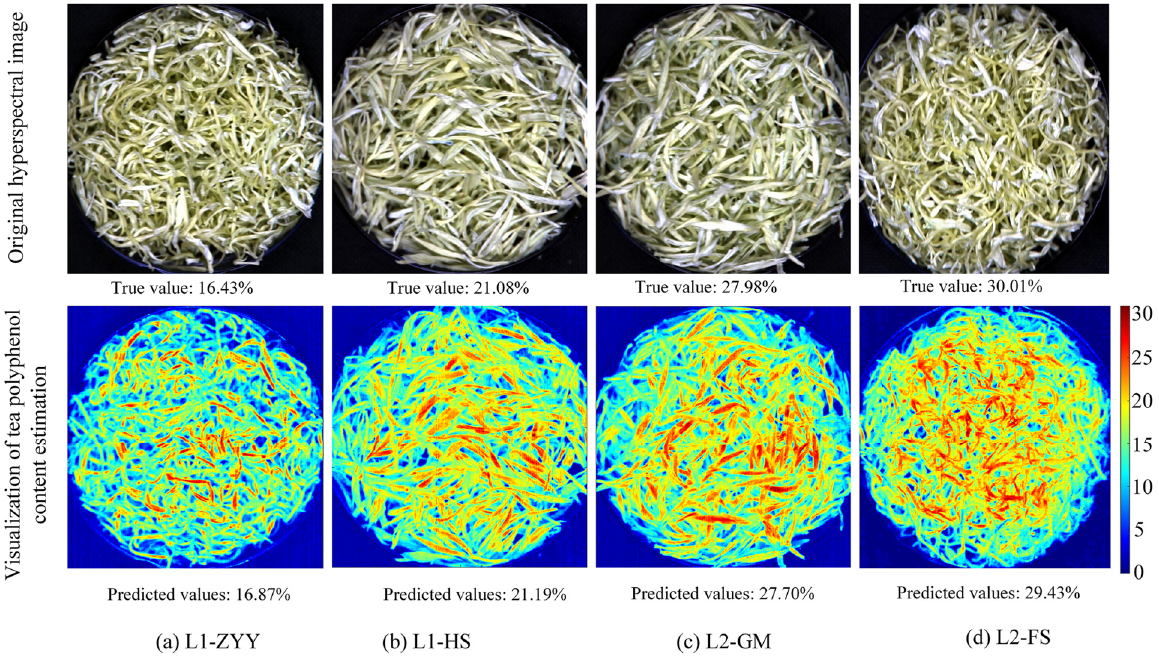
Figure 9. Distribution map of polyphenol content of different tea, including ( a ) L1-ZYY, ( b ) L1-HS, ( c ) L2-GM, and ( d ) L2-FS.